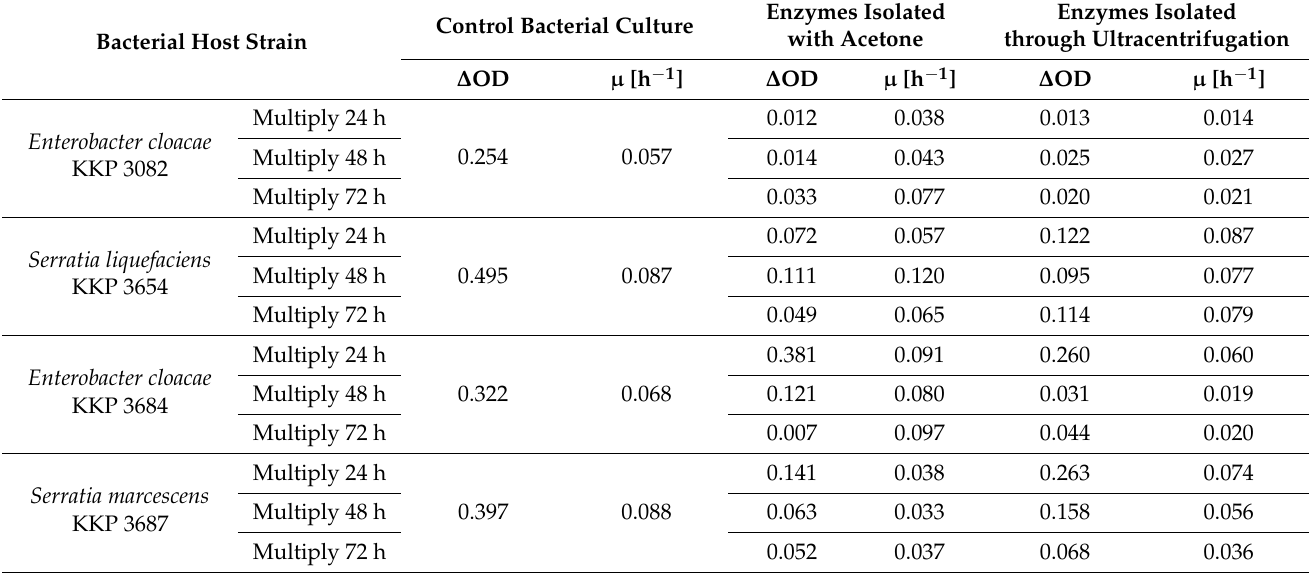
Table 5. Values of specific growth rate coefficient of tested bacterial cultures after addition of enzymes after 72 h propagation ( n =